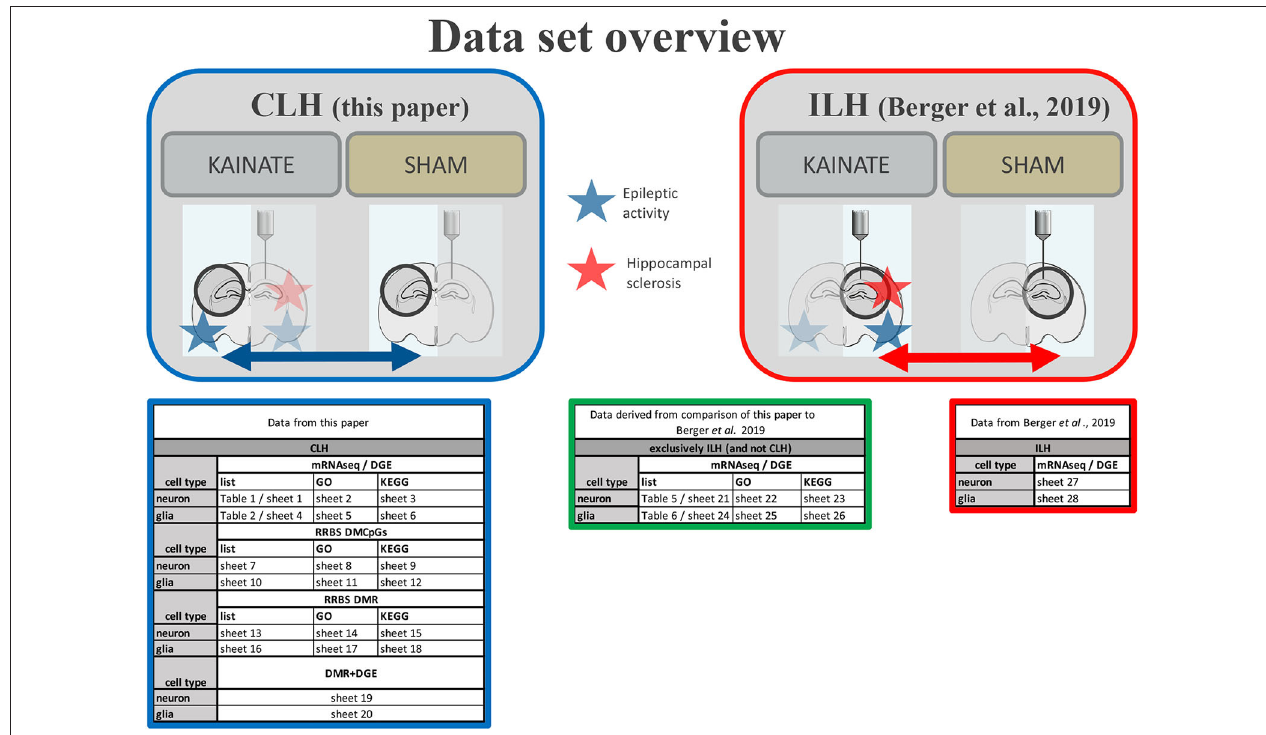
FIGURE 2 | Data set overview. Overview of provided data in paper ( Tables 1 , 2 , etc.) and Supplementary Table (sheets 1, 2, etc.) from the CLH (comparison of the contralateral hippocampi of the kainic acid group vs . sham group) and the ILH (comparison of the ipsilateral hippocampi of the kainic acid group vs . sham group as in Berger et al.